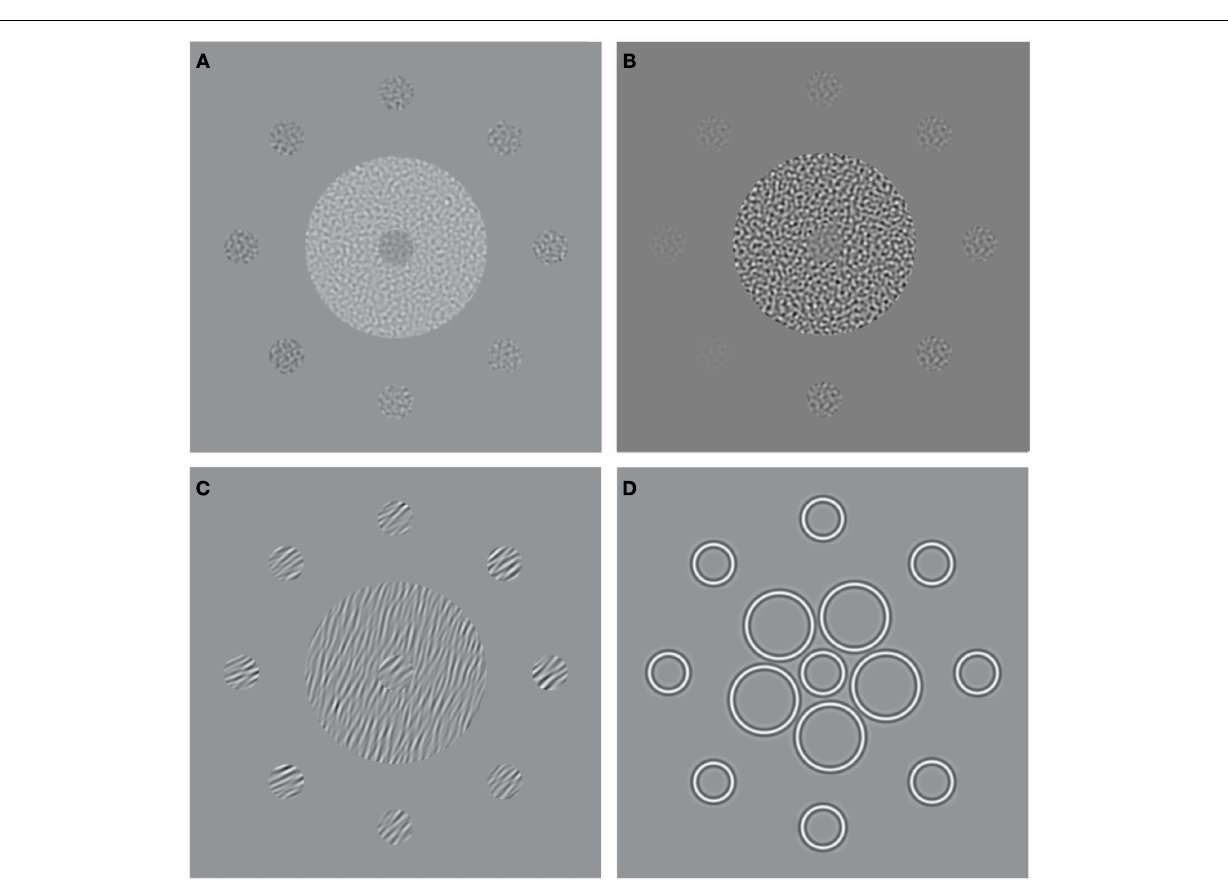
FIGURE 1 | Stimuli used to measure surround suppression for judgments of (A) luminance, (B) contrast, (C) orientation, and (D) size. The stimulus consists of a central patch (the “reference”) presented within a surround of (A) higher luminance, (B) higher-contrast, (C) more anti-clockwise orientation,